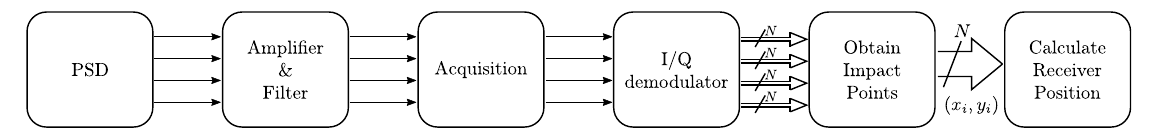
Figure 2. Flowchart of the positioning